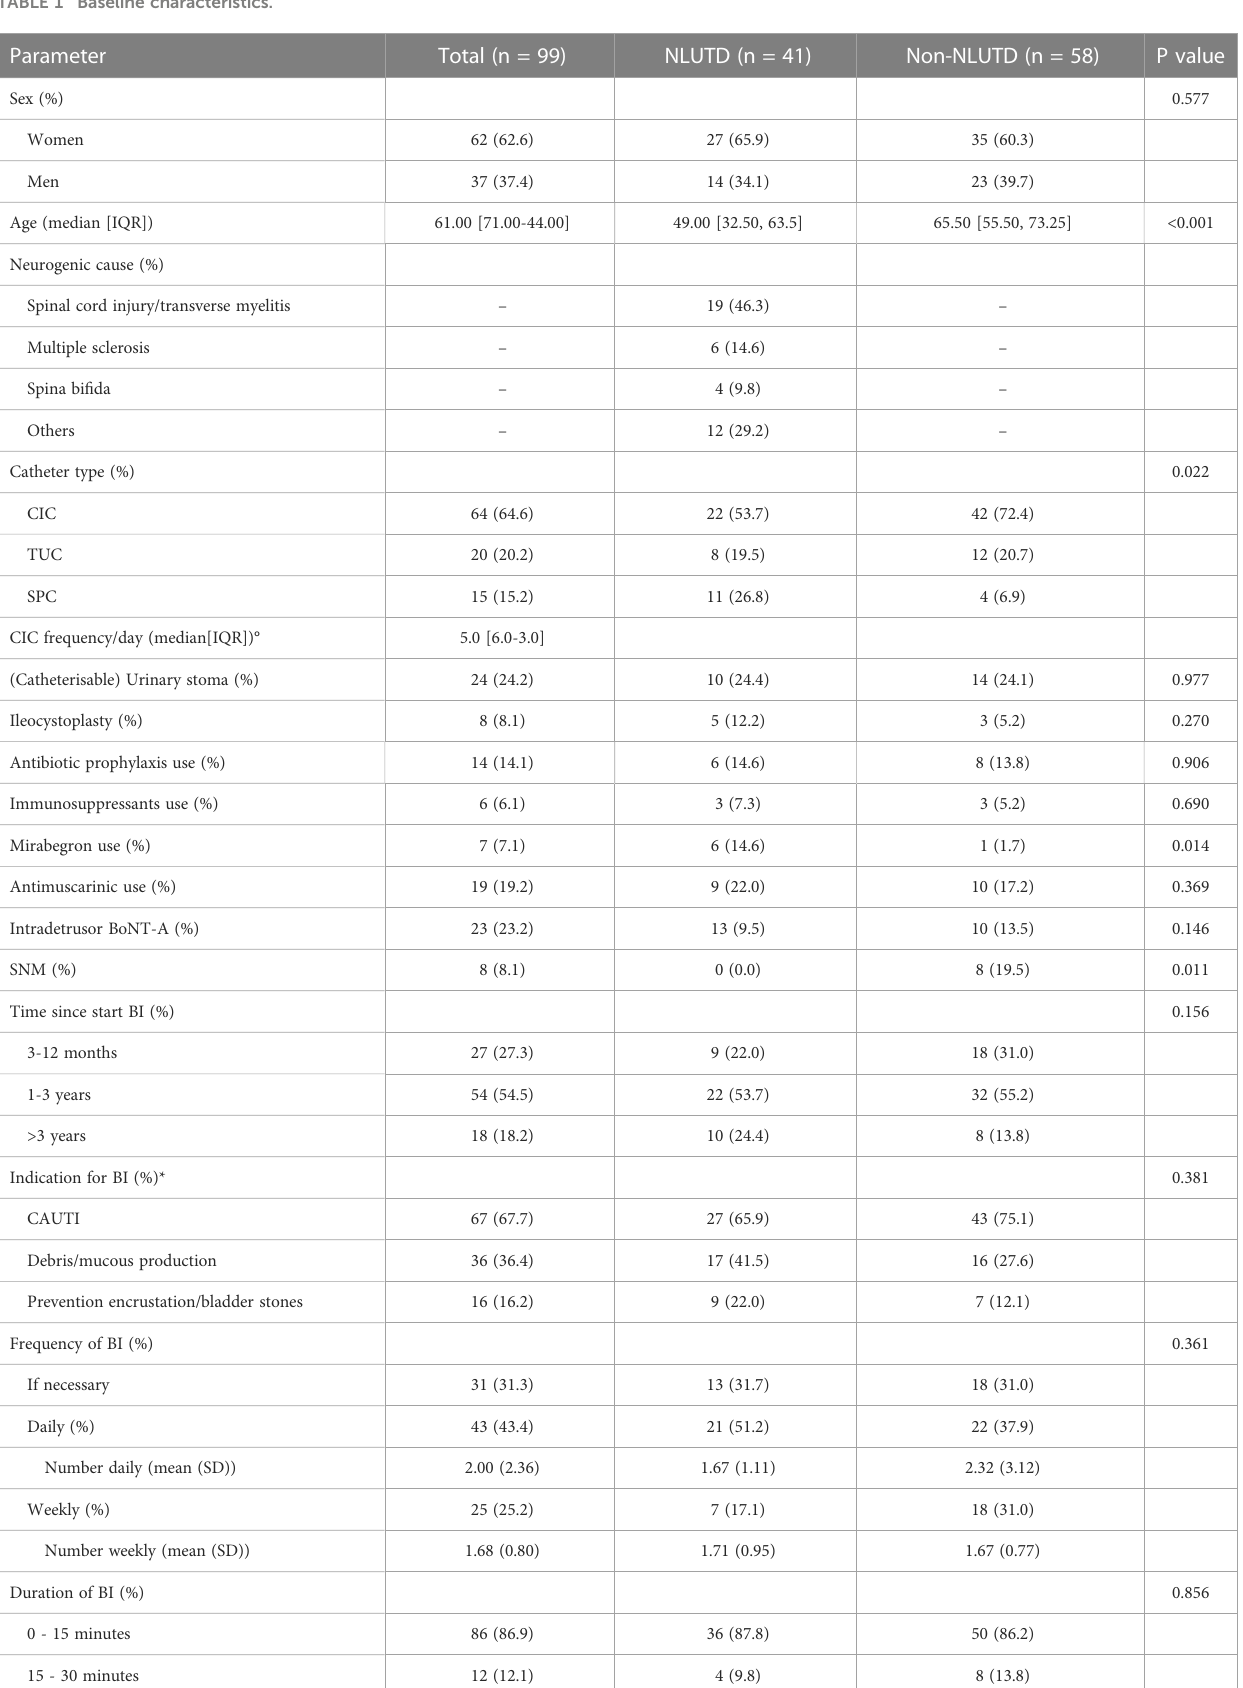
TABLE 1 Baseline